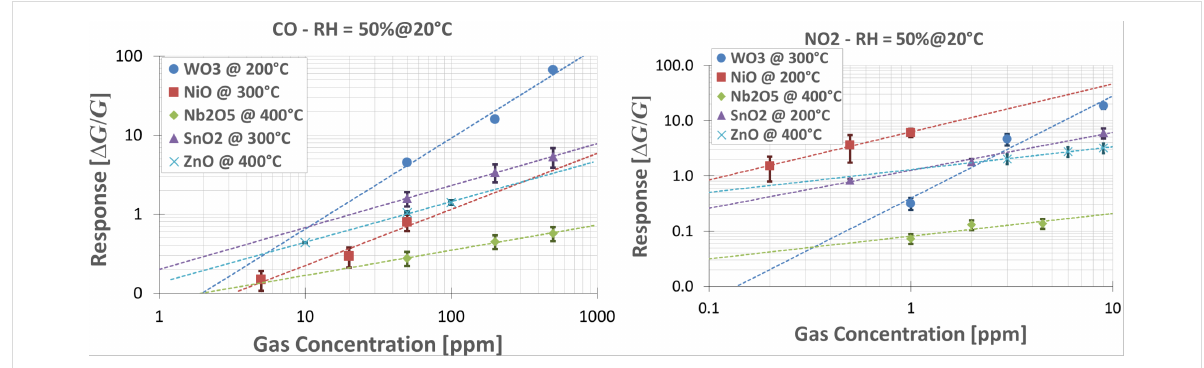
Figure 11: Calibration curves and power-law fitting for CO (left) and NO 2 (right). The relative humidity was kept constant at 50%, the temperature was 20 °C.